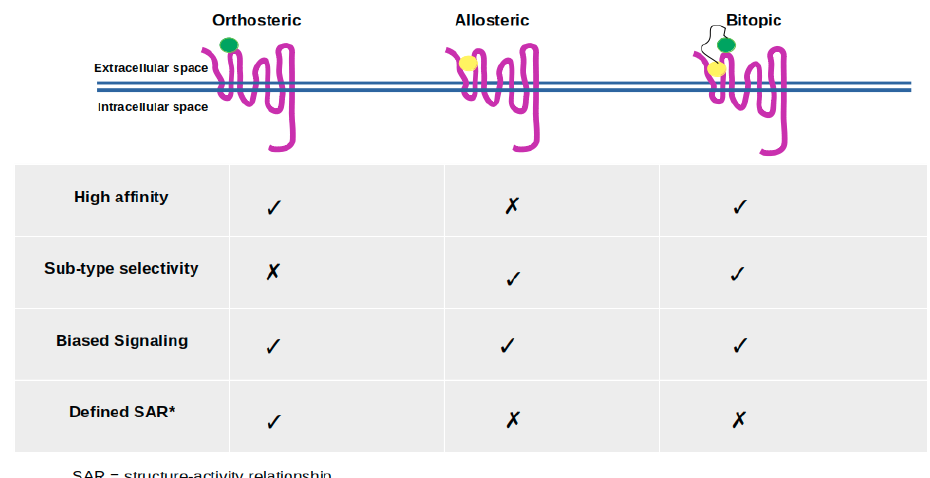
Figure 3. The orthosteric ligand, which is shown with green beads, targets orthosteric binding sites of the receptor, whereas the allosteric ligand, which is shown with yellow beads, targets a topologically different site named allosteric site. Bitopic ligand consists of two ligands that target both orthosteric and allosteric sites. The relevant key signaling properties for three types of targeting are indicated—inspired by Kruse et al.